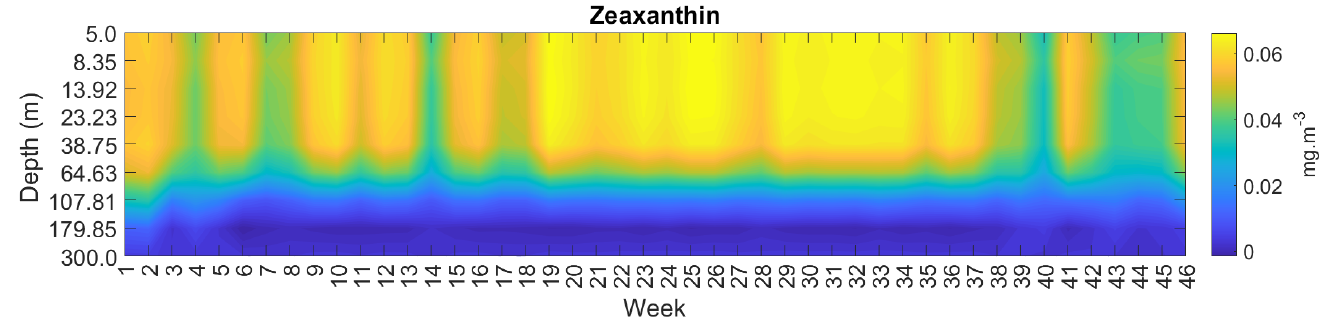
Figure 7. zeax inverted profiles over